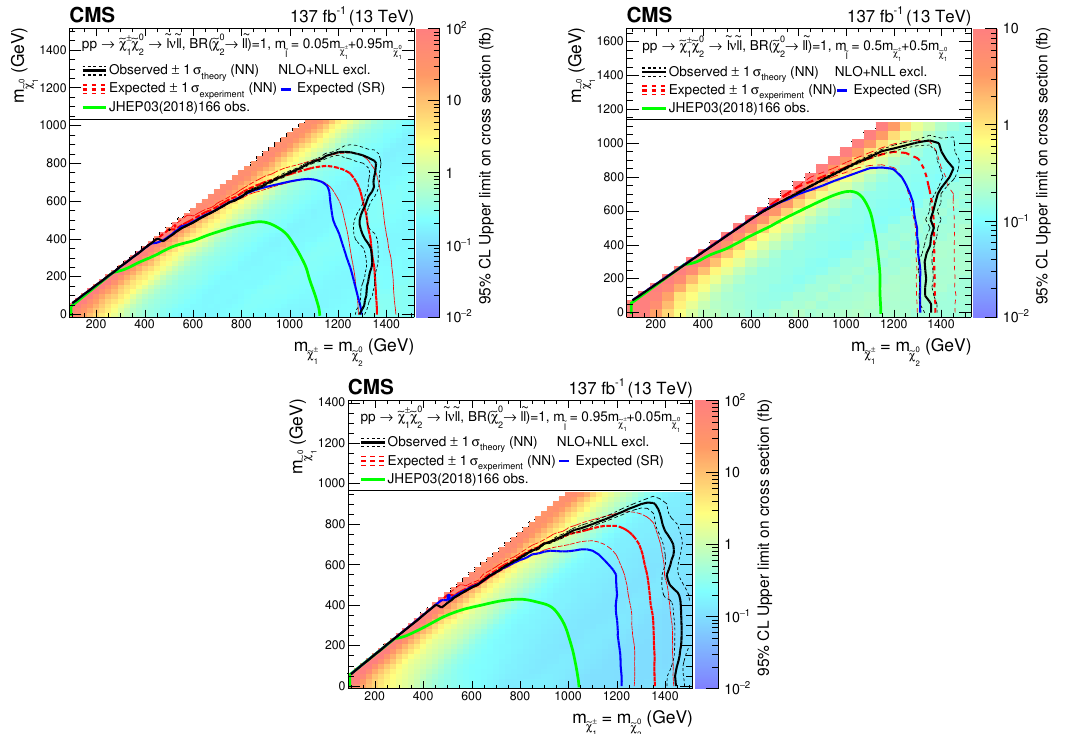
0 production with flavor-democratic slepton- 2 1 e c plane indicates versus m 0 0 e c e c 1 2 ± 0 production cross sections. The contours delineate the mass e c 2 1 e c ( ± 1 standard deviation of the theory bounds obtained with the experiment